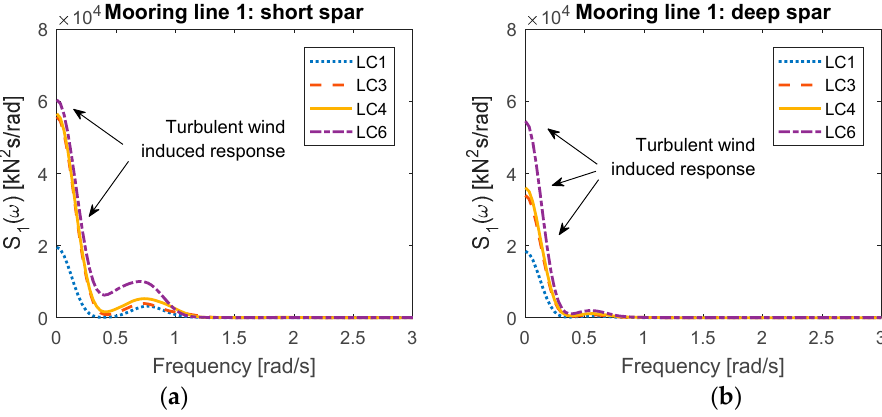
Figure 15. Power spectra of the tension in Mooring Line 1 under all loading cases: ( a ) Short spar VAWT; ( b ) Deep spar VAWT.